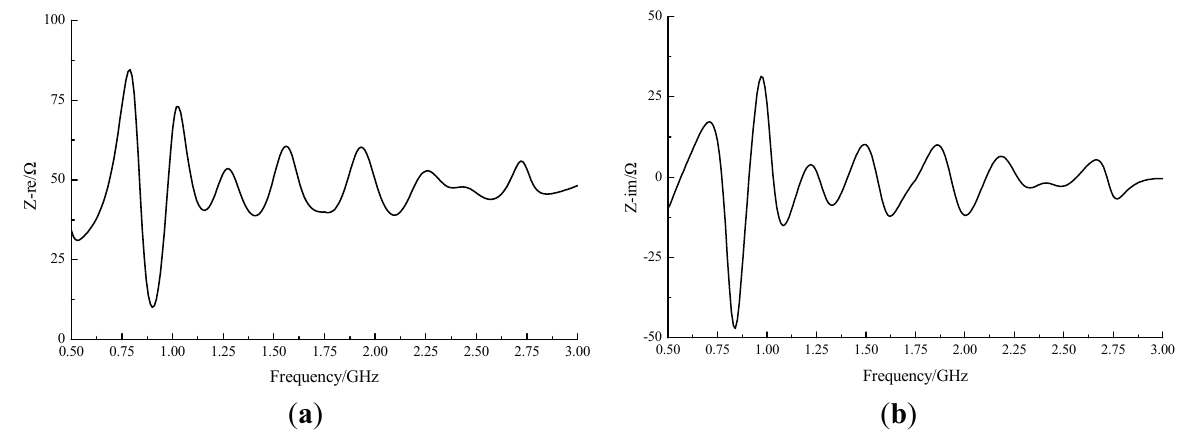
Figure 5. Impedance simulation results of the ESA: ( a ) real impedance; ( b ) imaginary